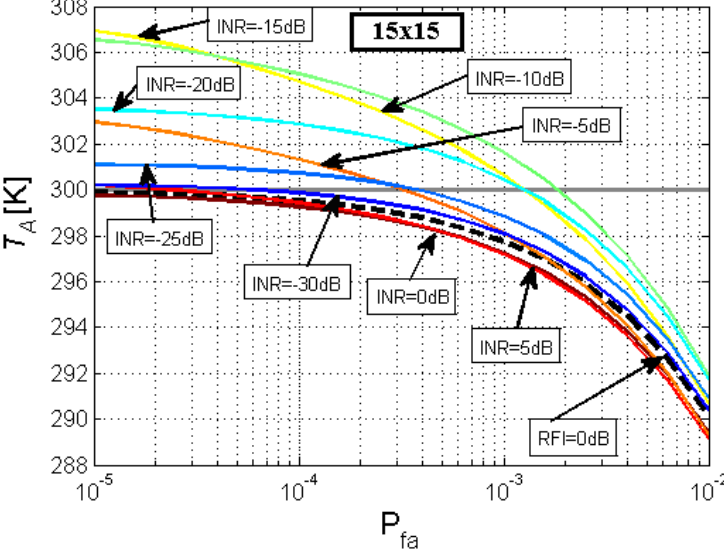
using a 15 × 15 A